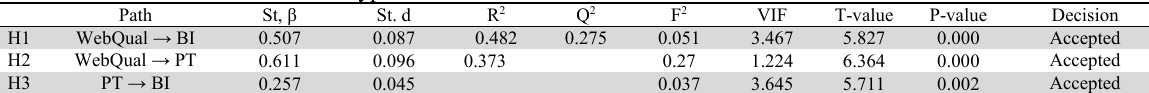
Structural Model with Direct Effects Hypothesis